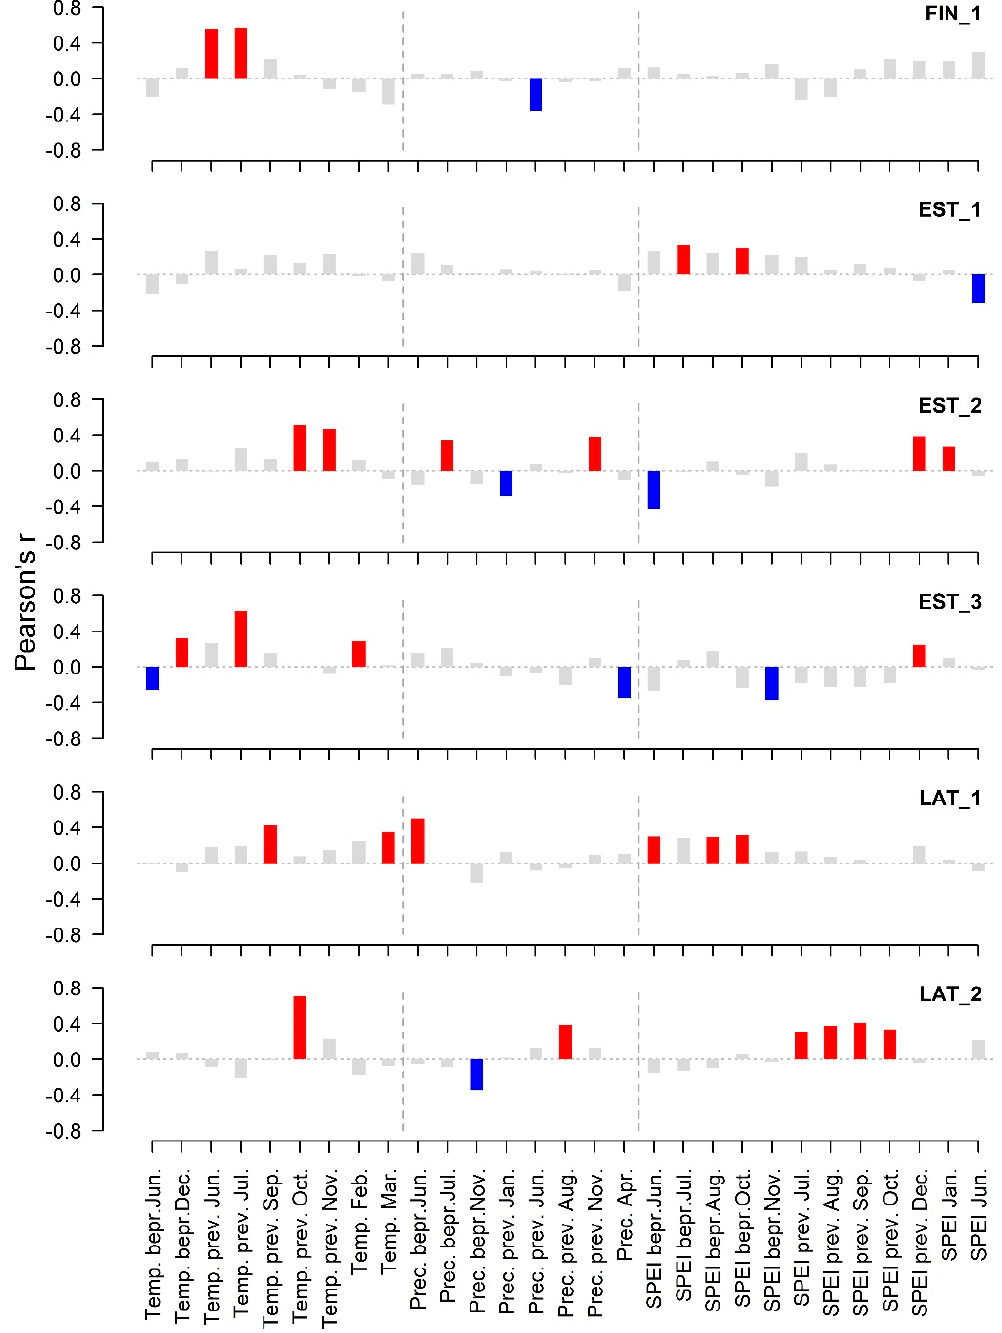
Figure 4. Bootstrapped Pearson correlation coefficients between residual chronologies of height increment of Scots pine from conventionally managed stands in Northern Finland, Estonia and Latvia and meteorological variables (monthly standardized precipitation evapotranspiration indices SPEI, precipitation sums, and mean temperature). bepr. and prev. denote meteorological conditions two and one year before the formation of increment, respectively. The significant correlations (at α = 0.05) are shown in colour. The analysis was conducted for the common period of 1955–2003.